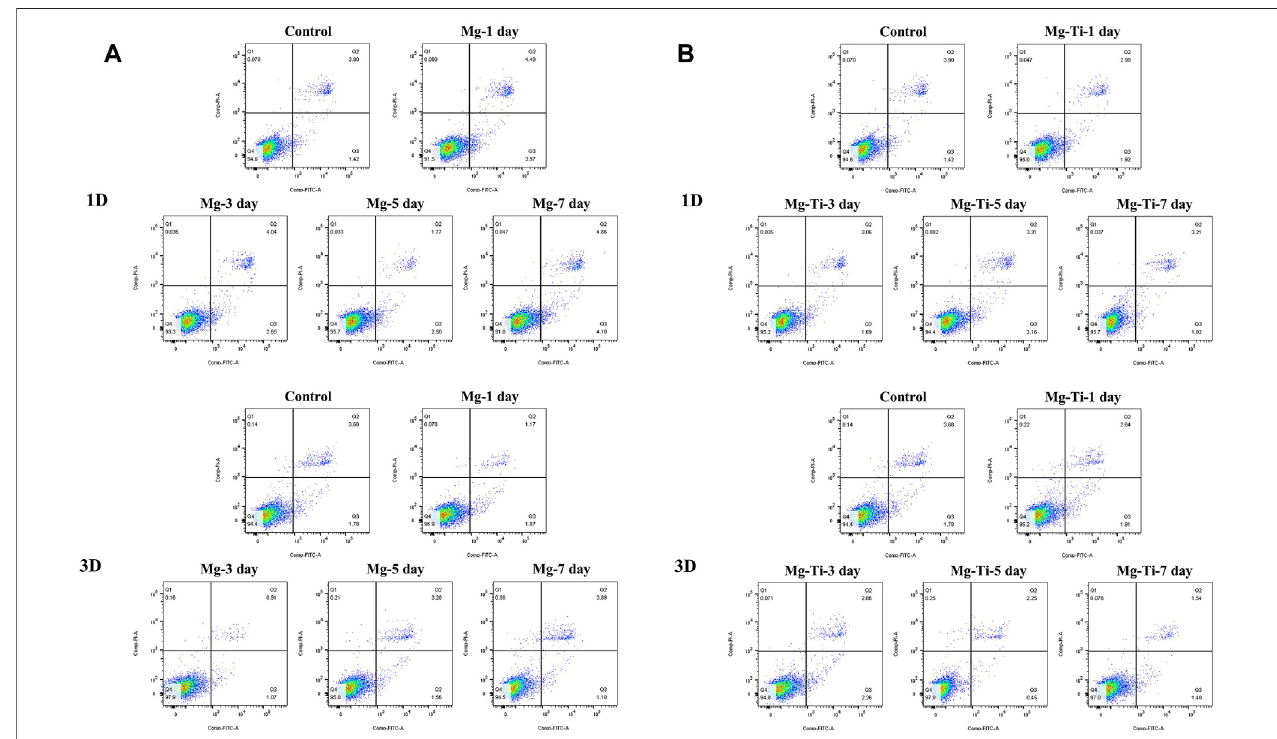
FIGURE 10 | Apoptosis of MC3T3-E1 cells cultured with extracts of degraded pure (A) Mg and (B) Mg-Ti composite for 1 day and 3